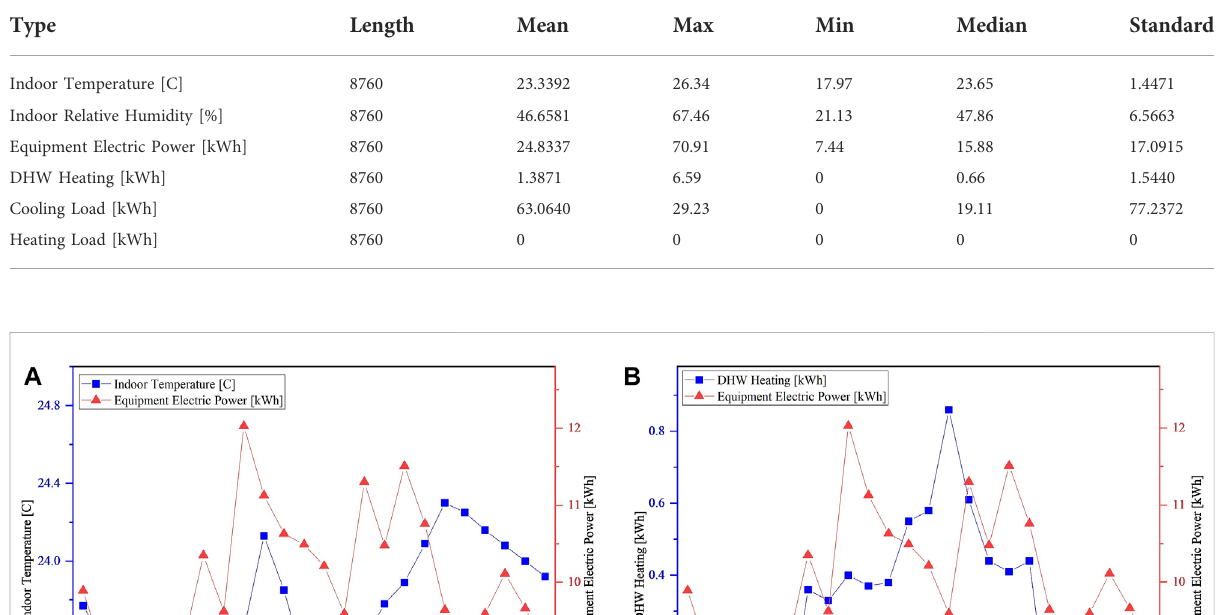
TABLE 2 The descriptive statistical characteristics of the study samples.